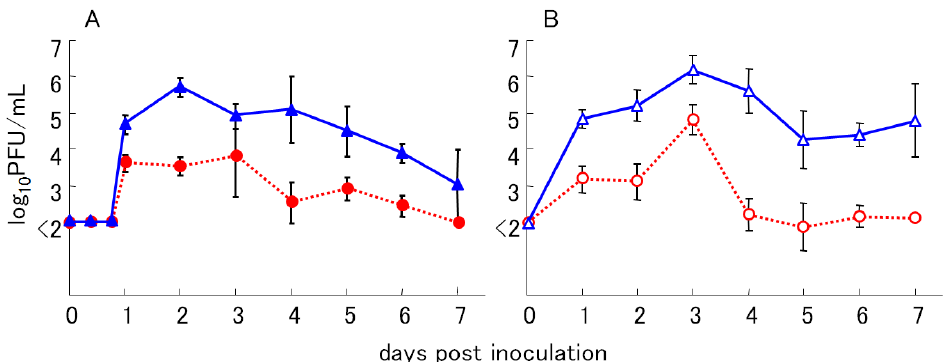
Figure 3. Viremic levels of young chicks subcutaneously inoculated with WN virus variants. Young chicks were inoculated with WN virus variants, 6-LP ( ▲ ) and 6-SP ( ● ) in experiment ( A ), and B-LP ( △ )and B-SP ( ○ ) in experiment ( B ). Two days old chicks were inoculated with 100 PFU of all variants (n = 4). The virus titers in sera were measured by plaque assay on BHK cells. Mean (±SD) titers are from triplicate